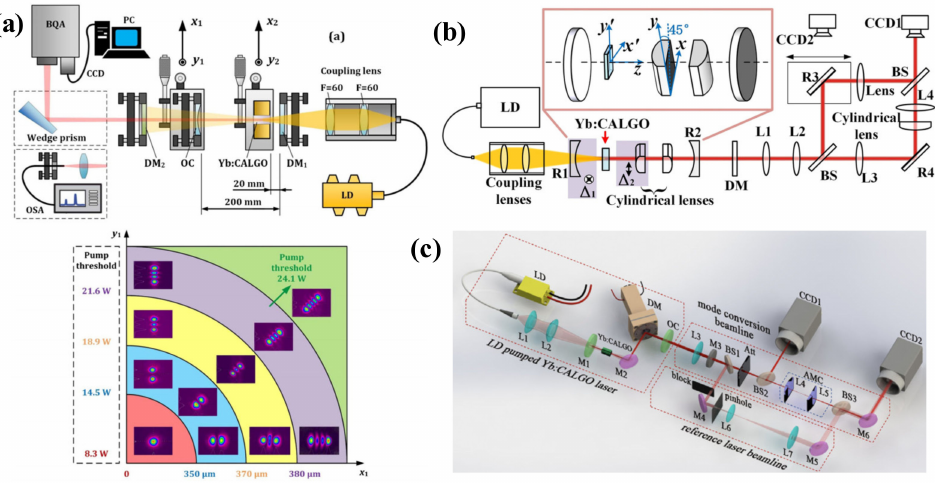
Figure 3. ( a ) Wavelength- and OAM-tunable Yb:CALGO laser [77]. ( b ) Two-dimensional tunable high order mode laser [83]. ( c ) Mode-tunable laser based on a mirror curvature dynamically controlled Z-shaped resonator [85]. ( a ) Reprinted with permission from ref. [77], ©The Optical Society. ( b ) Reprinted with permission from ref. [83], the American Physical Society. ( c ) Reprinted with permission from ref. [85], ©The Optical